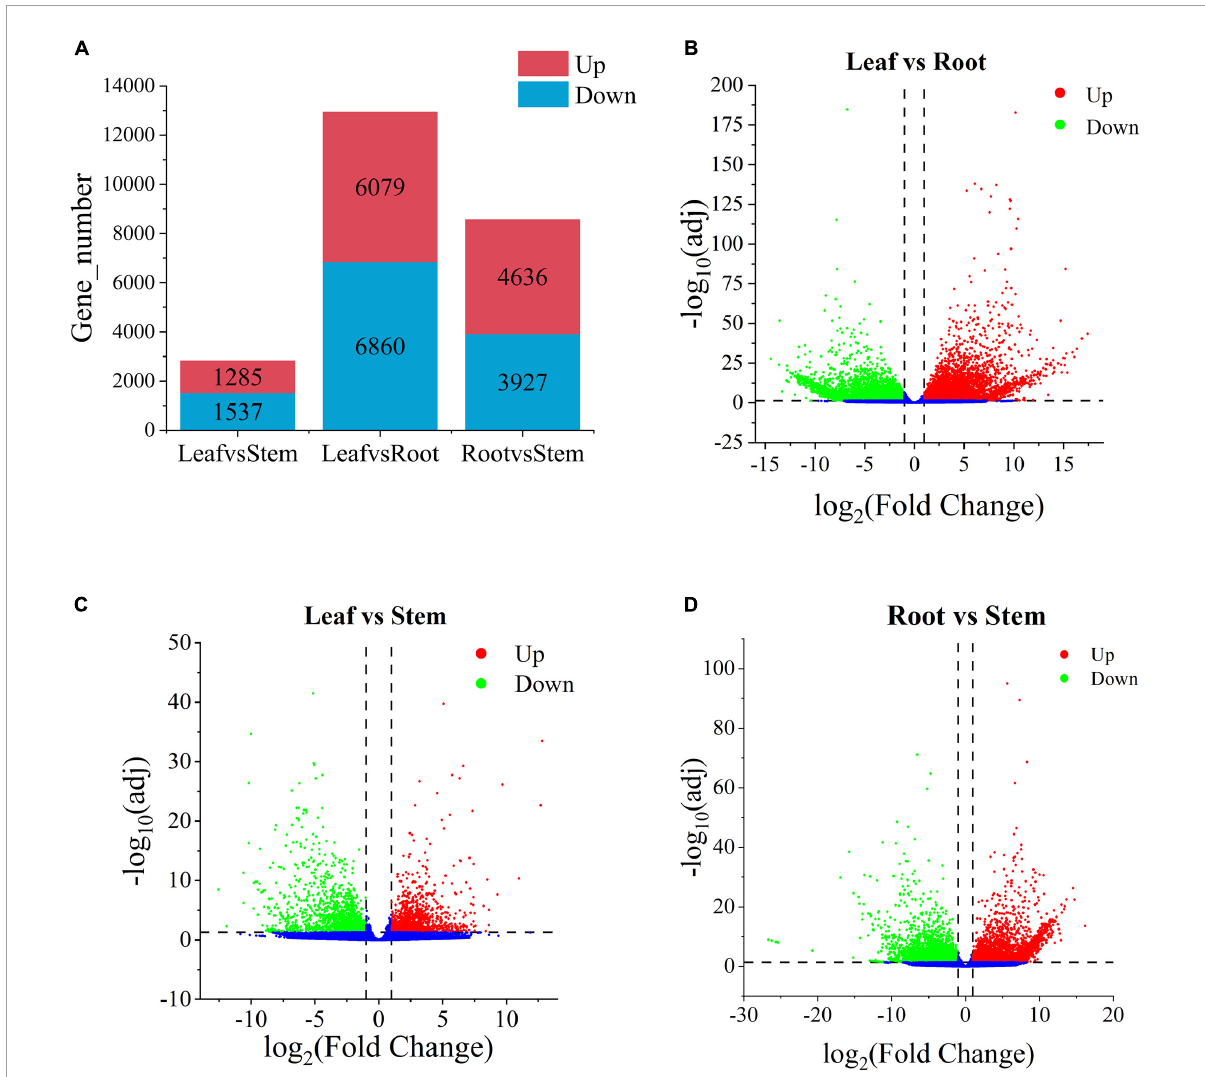
FIGURE5 Histogram of the number of differential genes in each tissue of and the volcanoplots of differential genes in Verbena officinalis . (A) Histogram of differential genes. (B) Volcanoplot of Leaf vs. Root. (C) Volcanoplot of Leaf vs. Stem. (D) Volcanoplot of Root vs. Stem DEGs. The screening criteria for DEGs are p < 0.05 and | log 2 FoldChange| > 1 by